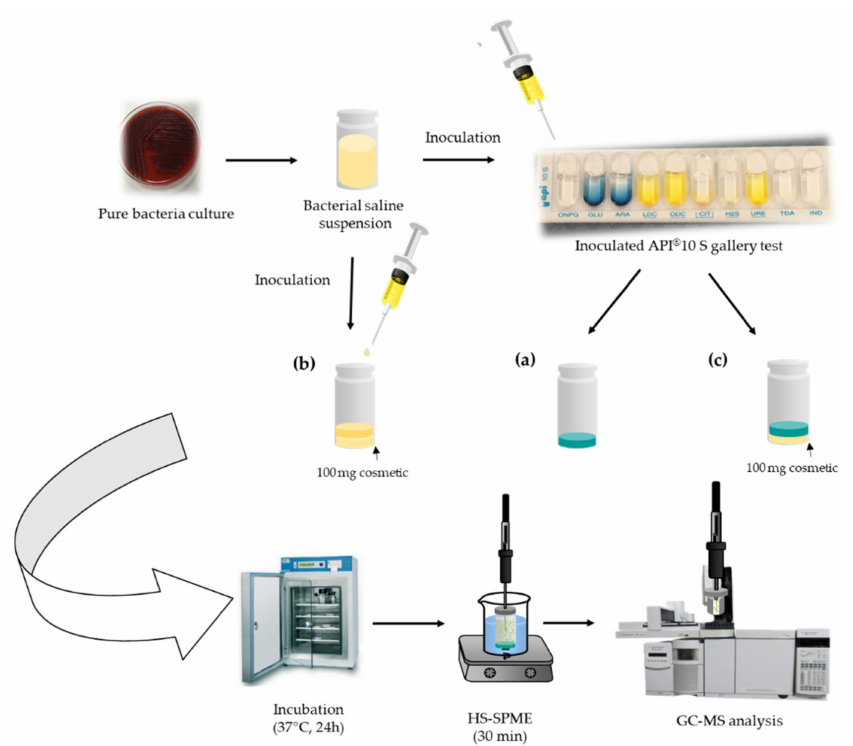
Figure 3. API-SPME-GC-MS experimental procedure for the analysis of inoculated ( a ) API ® 10 S gallery, ( b ) cosmetic, and ( c ) API ® 10 S +